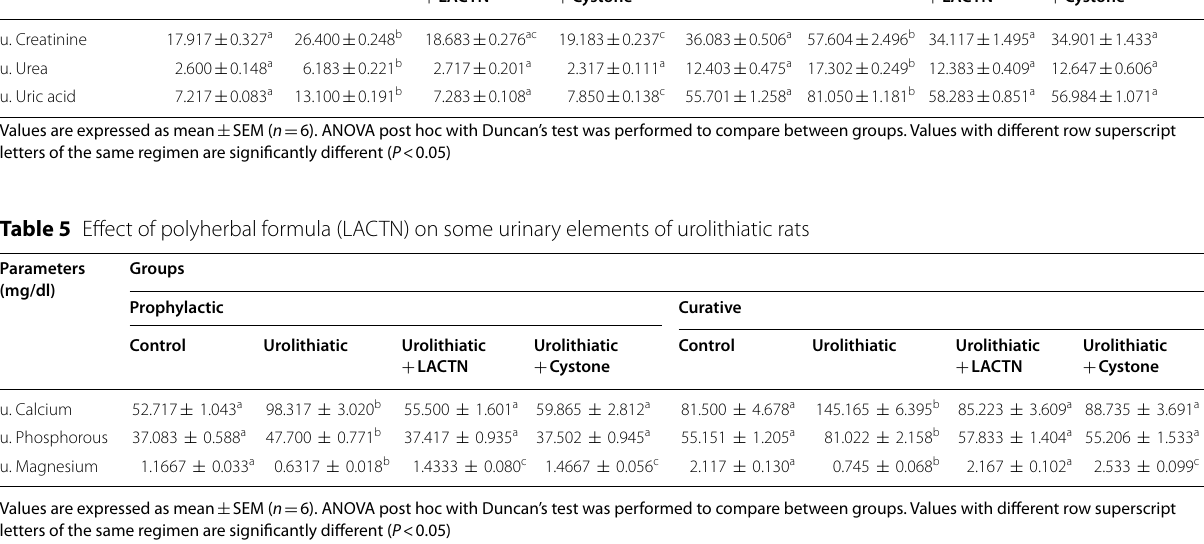
Table 4 Effect of polyherbal formula (LACTN) on some urinary kidney function markers of urolithiatic rats Parameters (mg/dl) Prophylactic